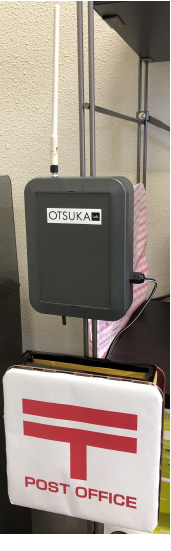
Figure 6. Prototype of Postbox 2 for the